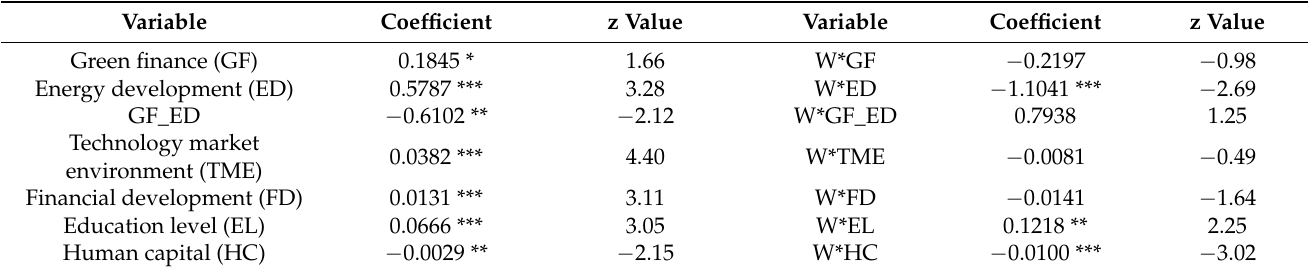
Table 6. Estimation results of spatial Durbin model.